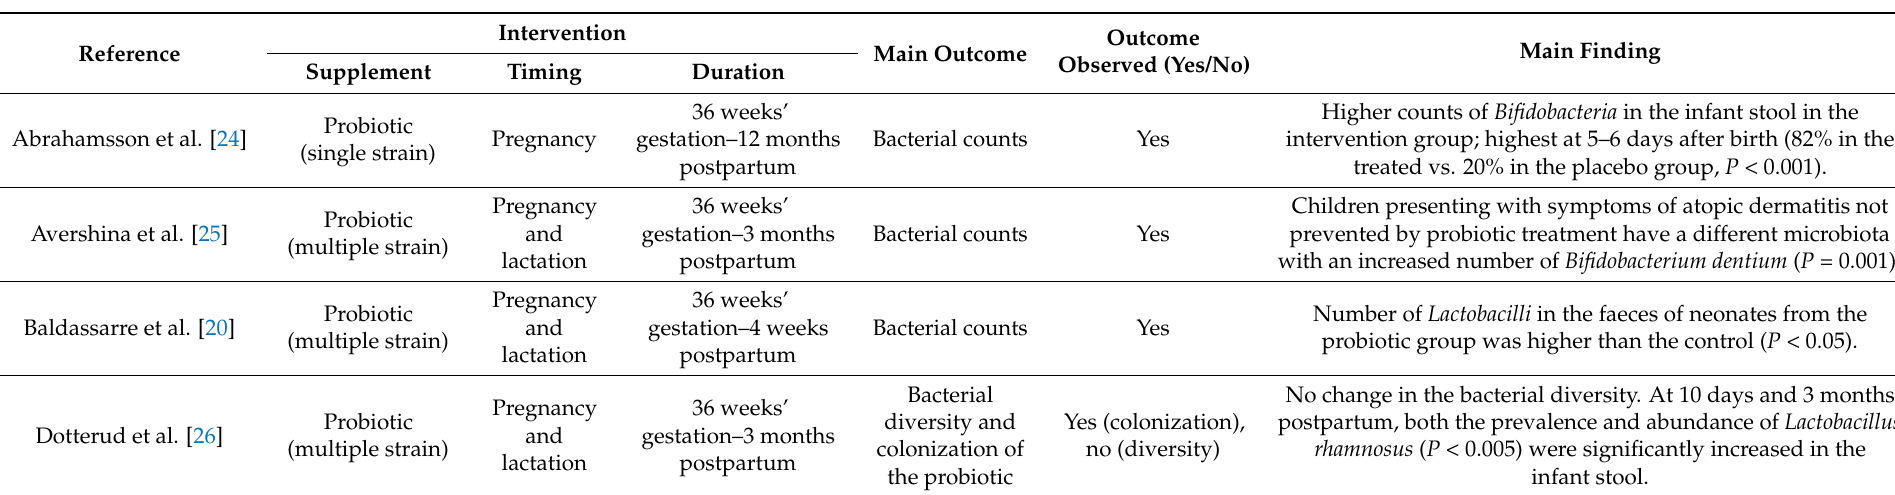
Table 2. Summary of results of the effects of maternal nutritional supplementation on the infant gut